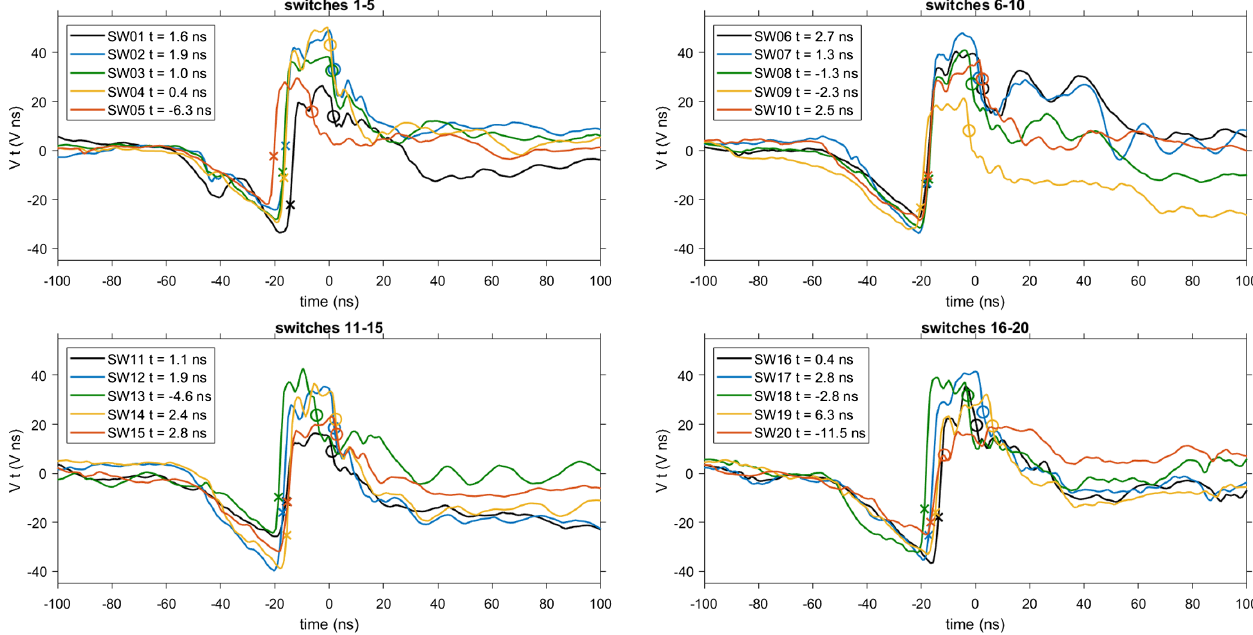
FIG. 3. Example of time-integrated switch monitor signals for the 20 bricks inside the CESZAR cavity. The cross marks identify the local maxima of the nonintegrated signals, while the circles indicate local minima corresponding to the switch closure. The timescale is relative to the average closing time of the 20